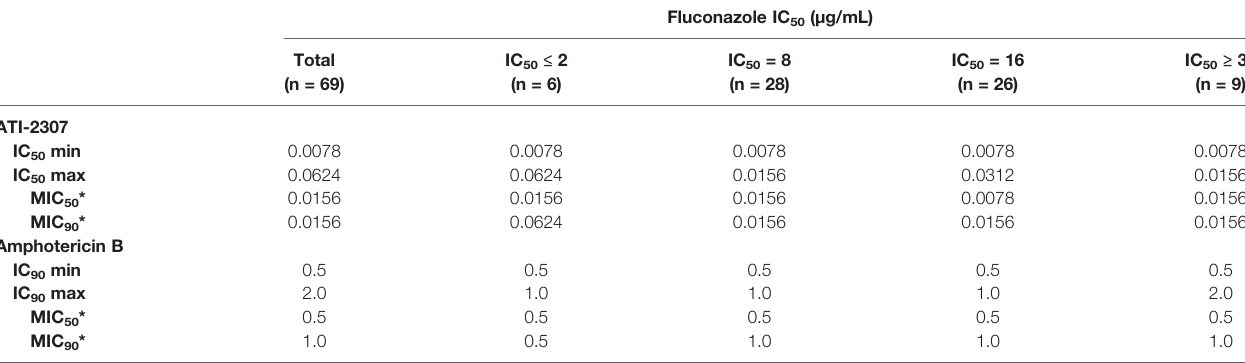
TABLE 2 | MIC 50 and MIC 90 for ATI-2307 and amphotericin B are equivalent across Cryptococcus neoformans clinical isolates with differing fl uconazole IC 50